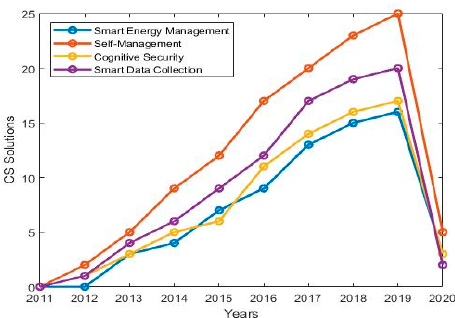
Figure 9. Trend of CS solution classification last over the decade.